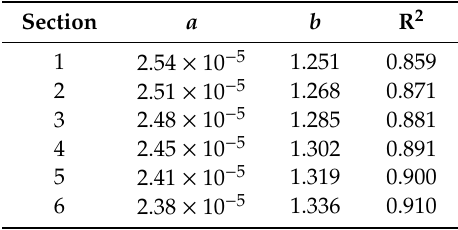
Table 7. Parameters a and b of the scaling laws K = K ( n e ) for each fixed value of R and relative values of R 2